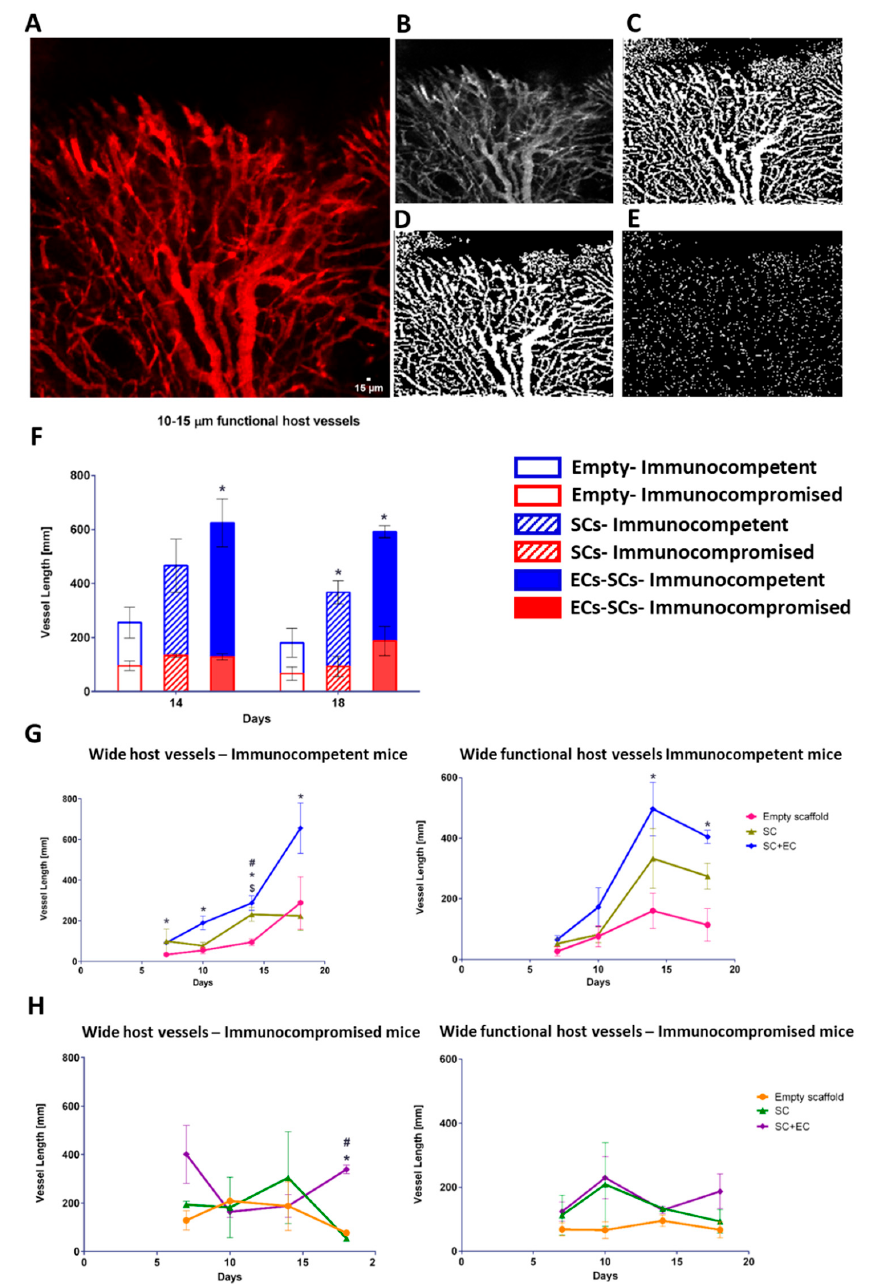
Figure 2. Intravital imaging. ( A ) A schematic presentation of engineered tissue transplantation into defects created in the rectus abdominis muscle of mice, and a representative image of a mouse with an abdominal imaging window (AIW) immediately post-surgery. The area of the transplanted graft is indicated by a yellow dashed circle. Empty, SC-only, and EC-SC-containing scaffolds were grown in vitro for 14 days prior to transplantation. Confocal intravital images were taken 7, 10, 14, and 18 days post-transplantation. Representative intravital confocal images of grafts transplanted into immunocompetent ( B ) or immunocompromised ( C ) mice, as viewed through the AIW. Green: mouse vessels; red: tetramethyl rhodamineisothiocyanate (TRITC)-conjugated dextran. The transplanted graft is indicated by a dashed circle. Scale bar = 1000 µm.